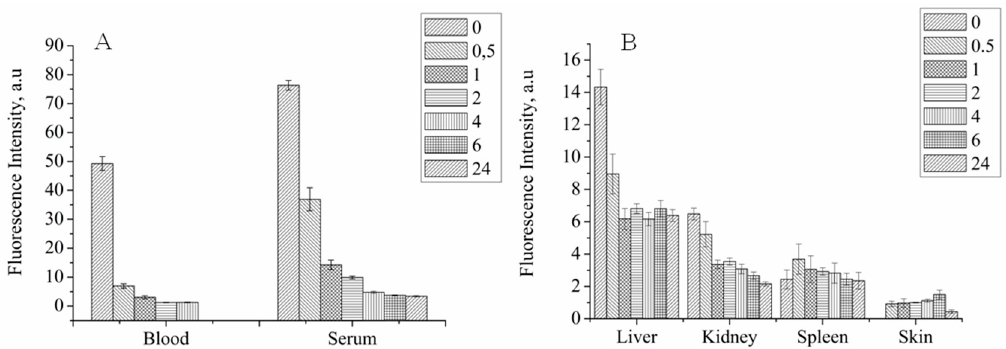
Figure 4. PS biodistribution in systemic circulation ( A ) and organs ( B ) after MNP-HSA@PS i.v. injection.